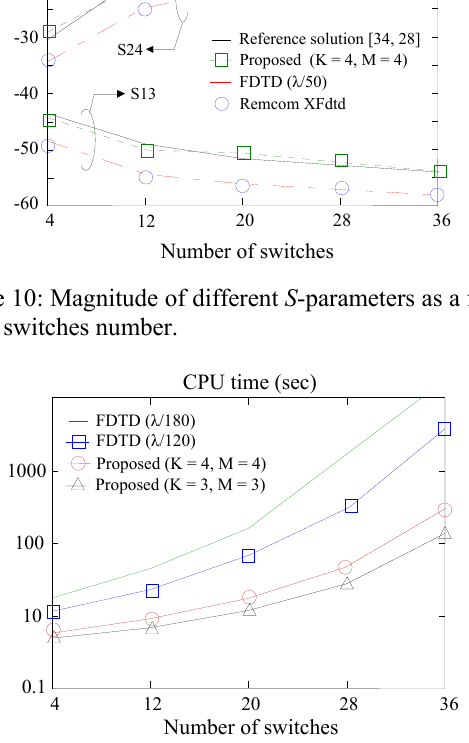
Figure 11: CPU-time required for the simulation of several splitter configuration as a function of the switches number.